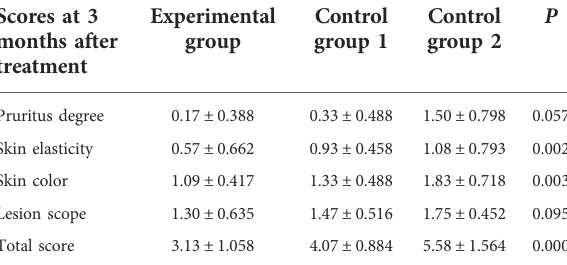
TABLE 5 Comparison among three groups at 3 months after